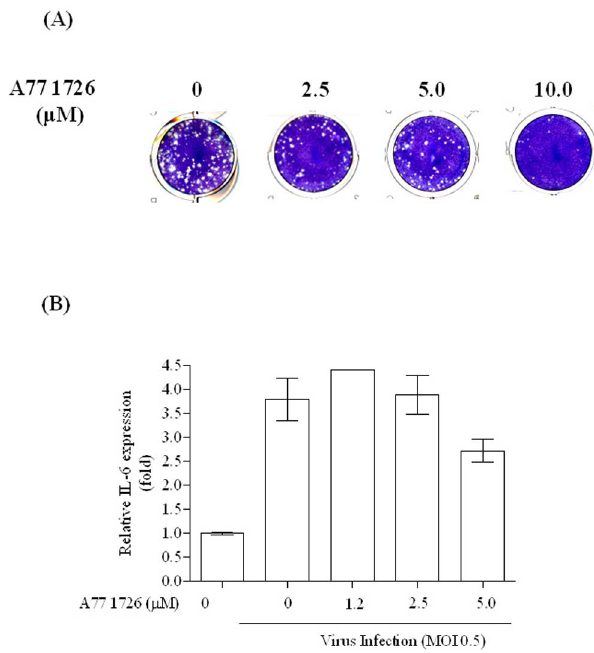
Figure 4. The active metabolite of Leflunomide, A771726, suppress virus production (A) and the expression of the pro- inflammatory cytokine IL-6 (B) in EV-A71-infected SF268 cells. SF268 cells were infected with EV-A71 (moi 0.5), and various concentrations of A771726 were added to the infected cells after viral adsorption time. At 48 h post-infection, the culture supernatants and cell lysates were collected for virus titration (A). In a parallel experiment, the IL-6 protein levels in cell culture supernatant were measured using ELISA (B). Each virus stock to be titered is serially diluted in10-fold series (dilution fold 10 2 4 ) and added to Vero cells. Data are the mean 6 s.e.m. from at least two parallel measurements per experiment.